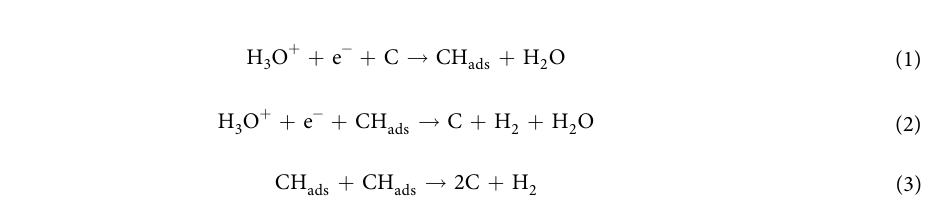
Figure 5. Schematic illustration of the mechanism governing the electrocatalytic HER on the MoS MWCNT